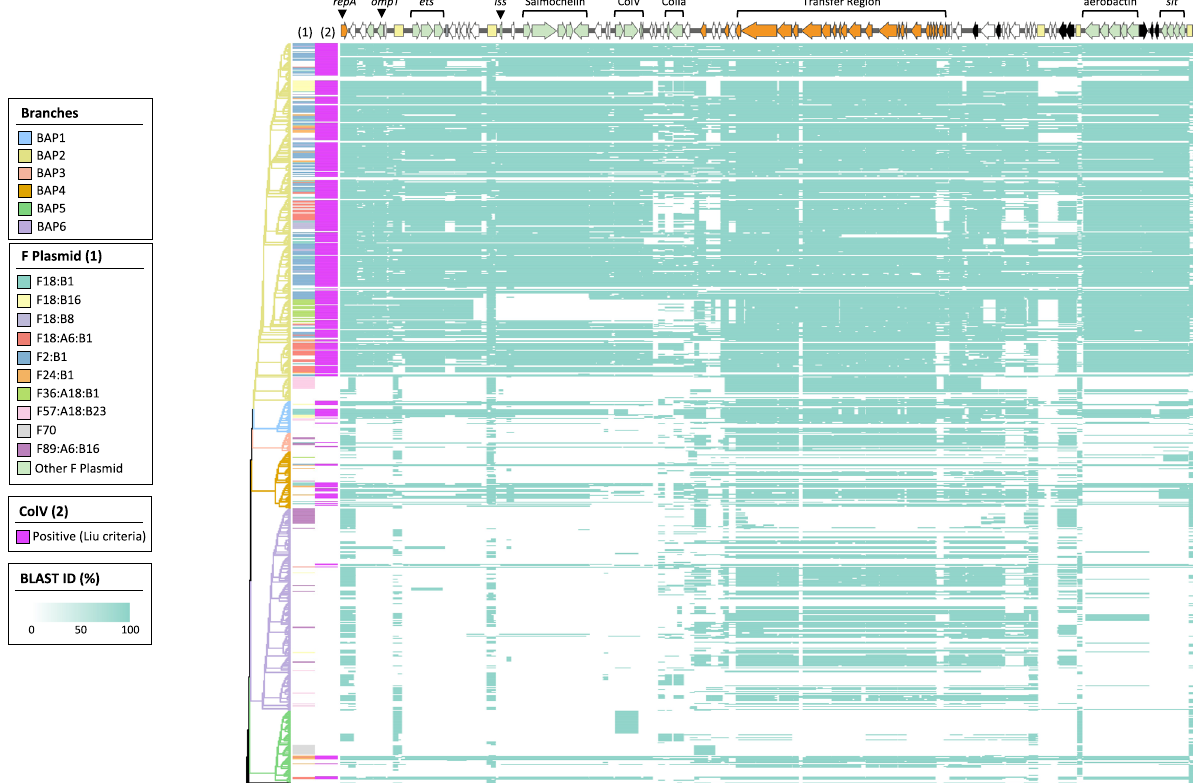
Fig. 4 Alignment of ST58 sequences to ColV plasmid pCERC4. Heatmap of nucleotide identity across 100 bp segments of the pCERC4 backbone. Tree branches are coloured by BAP cluster. F plasmid replicon sequence type (RST) and ColV presence are indicated in panels (1) and (2).